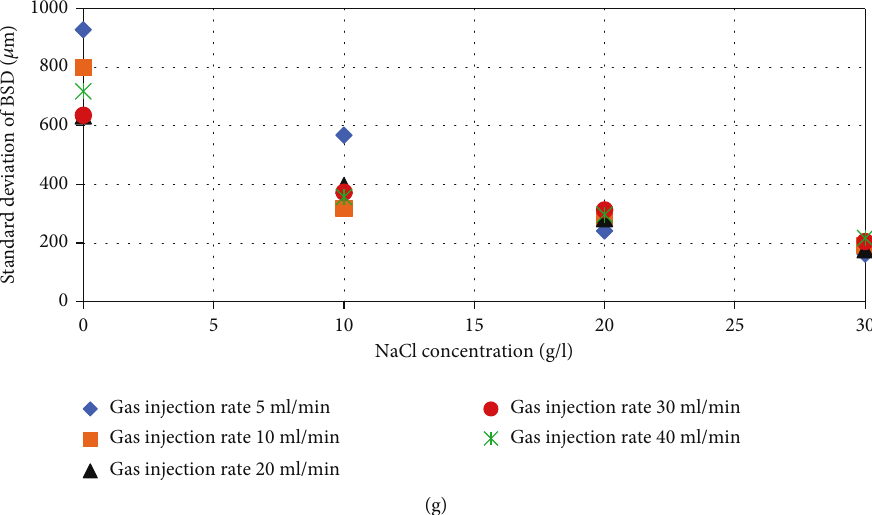
Figure 8: The e ff ects of sodium chloride (NaCl) concentration on bubble size distribution (BSD) for fi ve di ff erent gas injection rates: (a) 5ml/min, (b) 10ml/min, (c) 20 ml/min, (d) 30 ml/min, and (e) 40ml/min. (f) The mean bubble size varied with NaCl concentrations and (g) the STD varied with NaCl